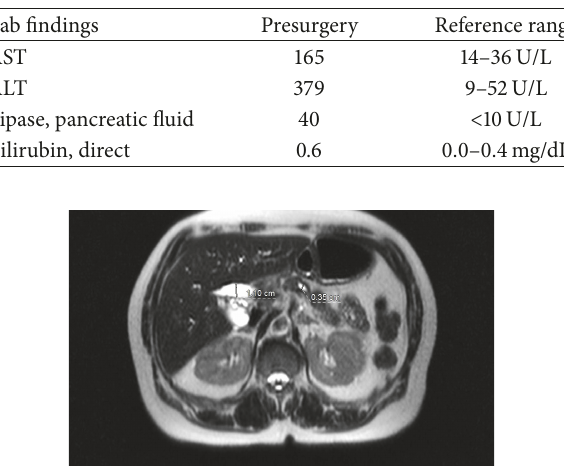
Table 1: Laboratory findings.